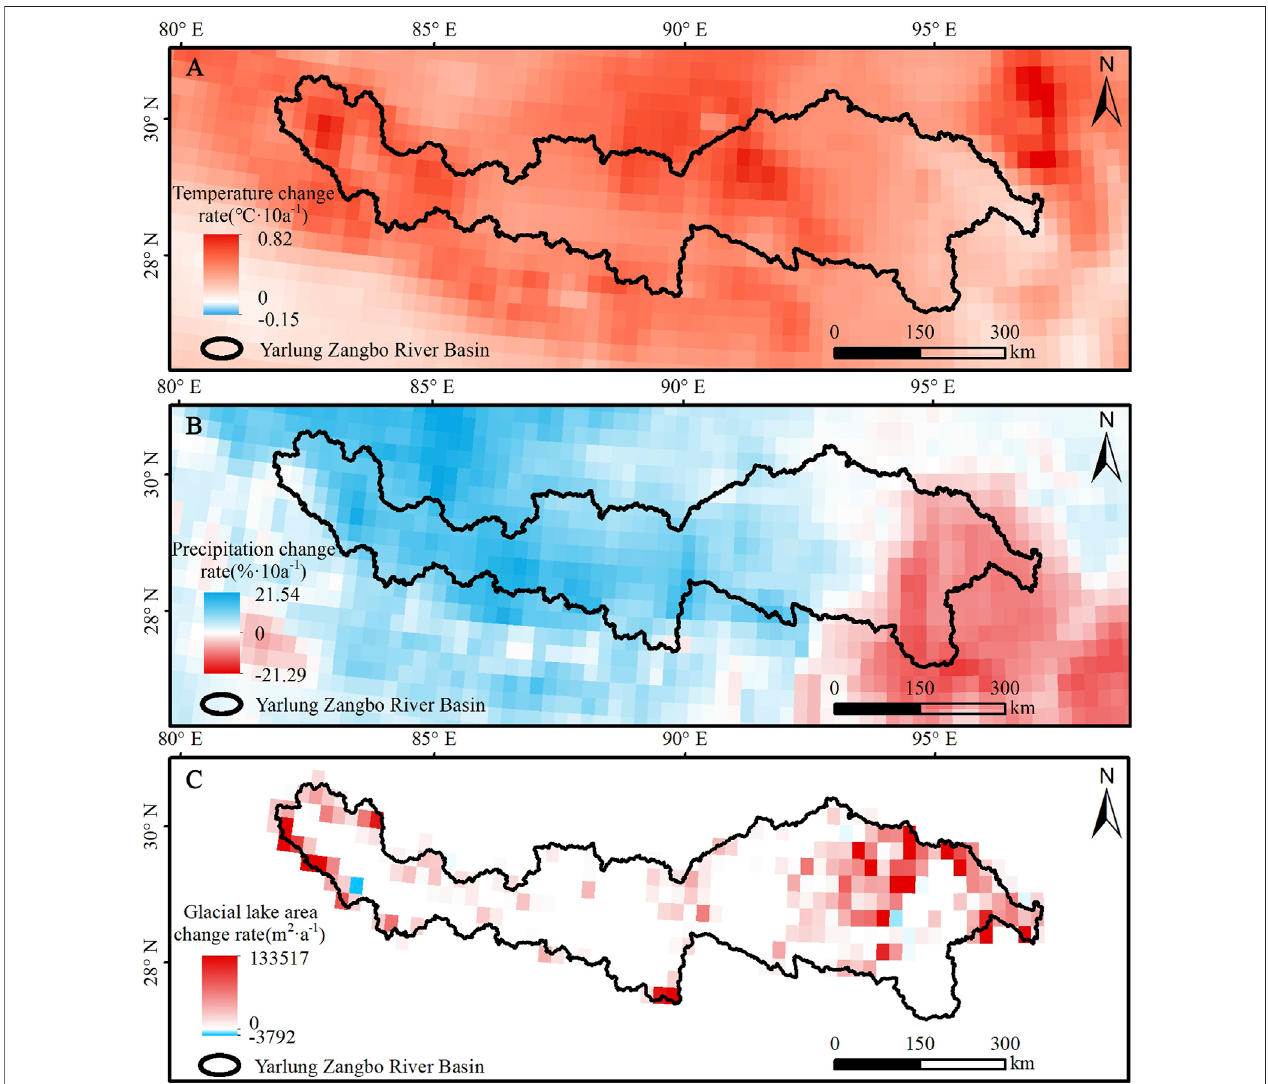
FIGURE 11 | Spatial variations in temperature, precipitation and glacial lake area change rate in the YZRB from 1990 to 2020. (A) Rate of temperature change ( ° C · 10a − 1 ), (B) rate of precipitation change (% · 10a − 1 ), and (C) rate of glacial lake area change (m 2 · a − 1 ).